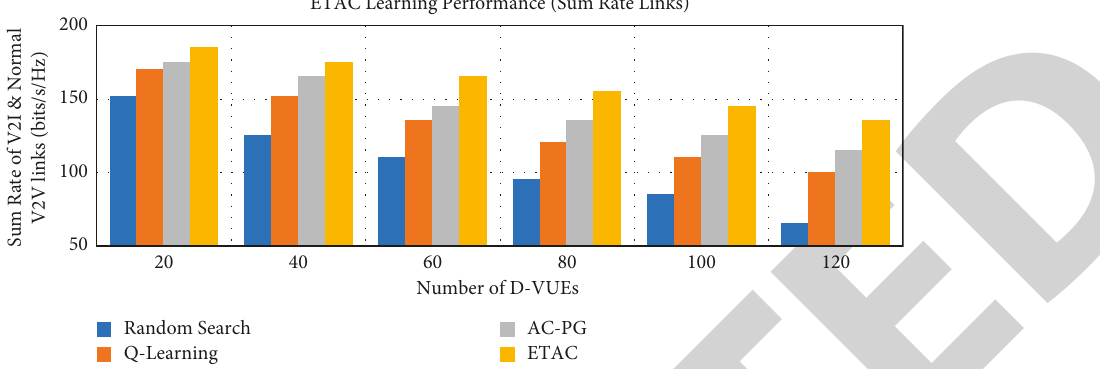
Figure 8: ETAC performance related to communication link sum rate within the D2D-V2V communication